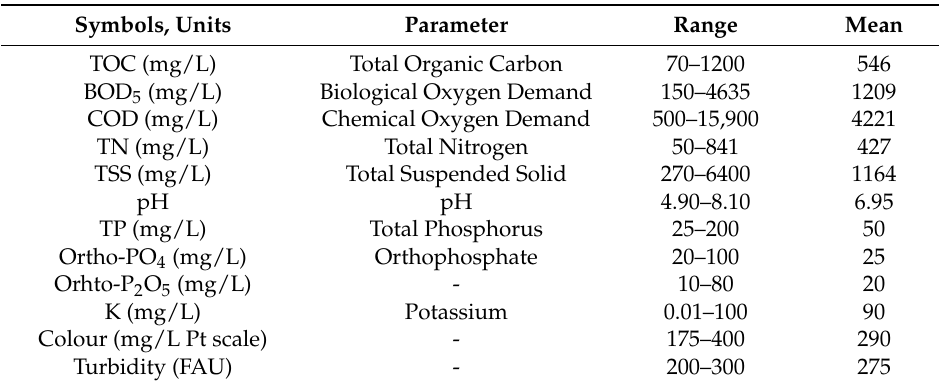
Table 1. General characteristics of meat processing wastewater